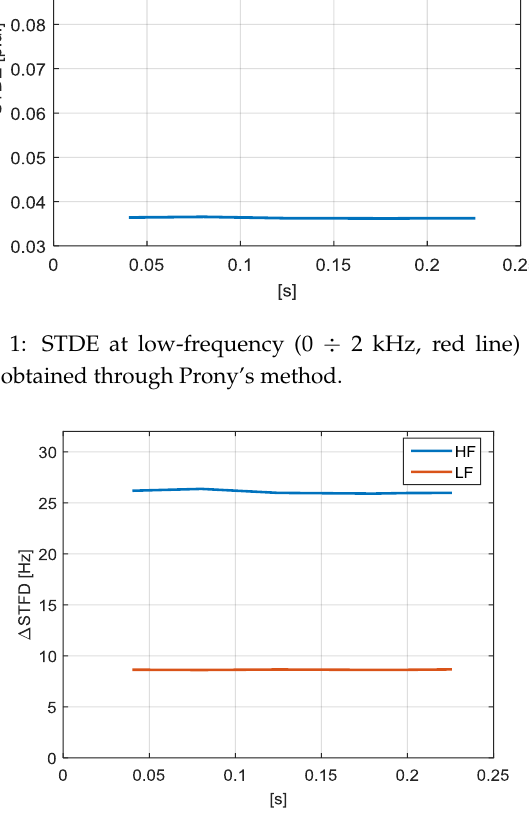
Figure 29. Case study 1: Δ STFD at low-frequency (0 ÷ 2 kHz, red line) and at high-frequency (2 ÷ 150 kHz, blue line) obtained through Prony’s method. Energies 2017 , 10 , 1633